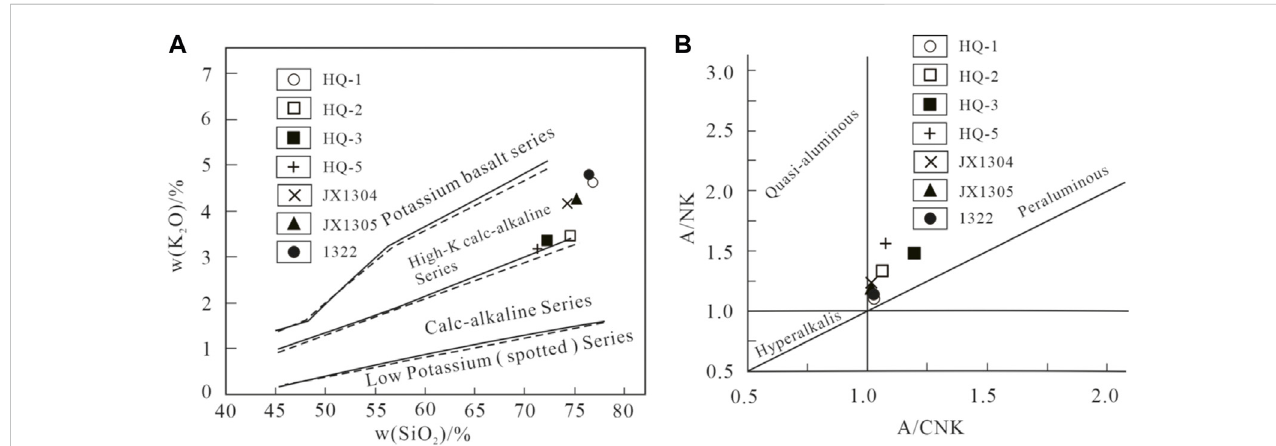
FIGURE 9 SiO 2 -K 2 O diagram (A) (real line after Peccerillo & Taylor, 1976; broken line after Middlemost, 1985) and A/CNK-A/NK diagram (B) (after Maniar & Piccoli, 1989) of granites in the Xinchenggou area, Dongning County.